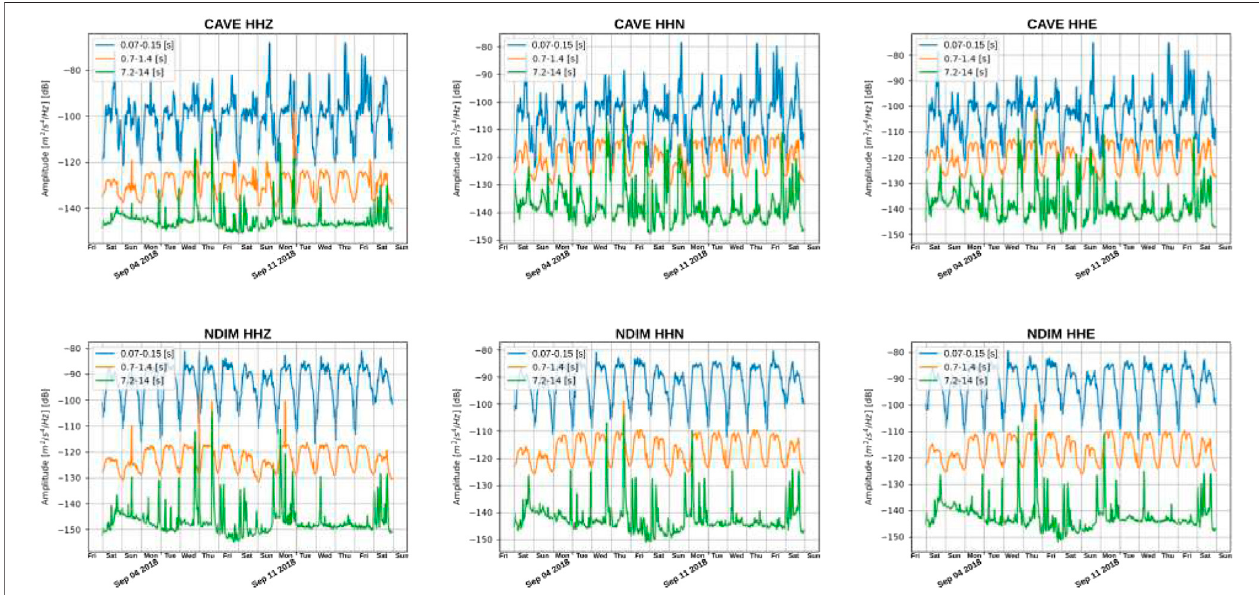
FIGURE4| Timevariabilityofthenoiselevels(PSDindB)averagedinthreedifferentperiodbands(0.07 ÷ 0.15s;0.7 ÷ 1.4s;7.2 ÷ 14s)forthethreecomponentsof CAVEandNDIMstationsusingthedatarecordedbetween1and15September,2018.Ineachsub-plot,thecorrespondingdaysoftheweekareshownontheabscissa axis in order to emphasise the diurnal variations of the noise level and the variations during the weekends.